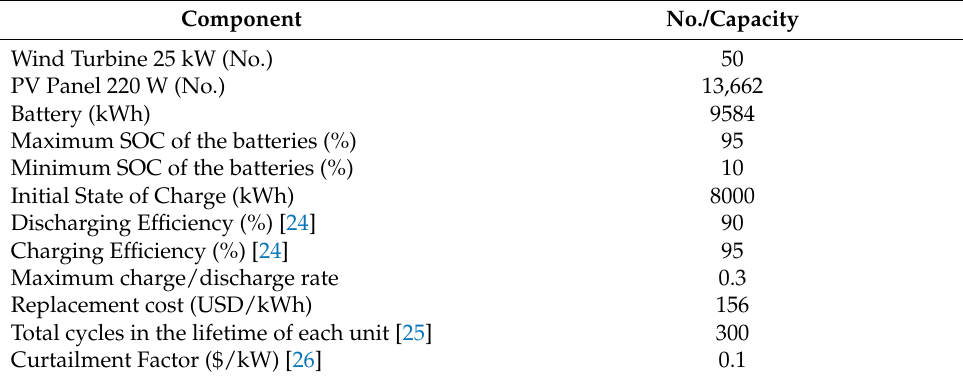
Table 5. The microgrid components and battery